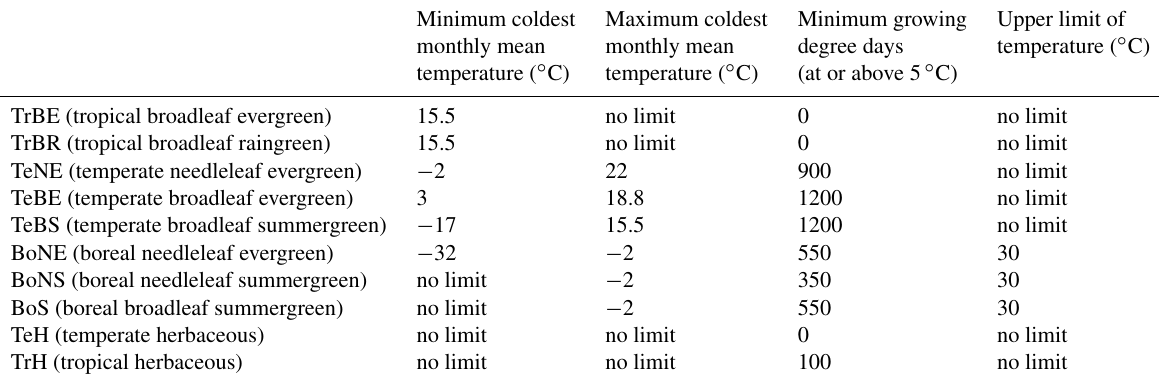
Table A1. Bioclimatic limits of the 10 available plant functional types in LPX-Bern. Minimum coldest Maximum coldest Minimum growing Upper limit of monthly mean monthly mean degree days temperature ( ◦ C) temperature ( ◦ C) temperature ( ◦ C) (at or above 5 ◦ C) TrBE (tropical broadleaf evergreen) 15.5 no limit 0 no limit 15.5 no limit no limit